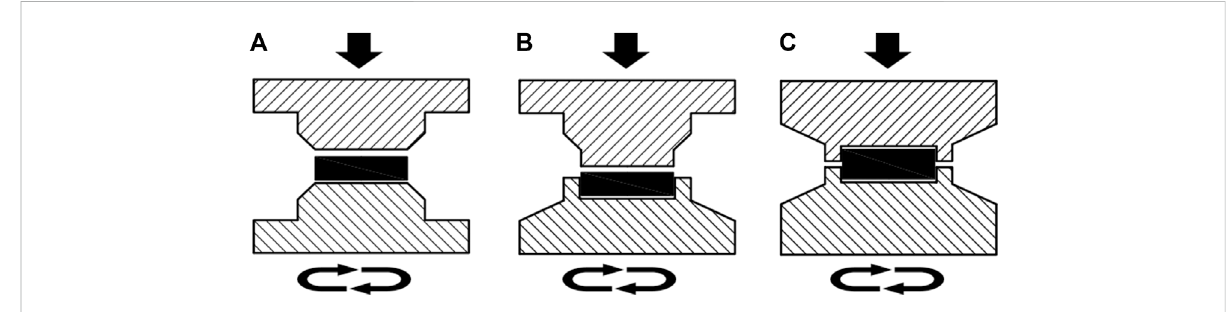
FIGURE 2 Schematical illustration of different conditions within the HPTed disk sample: (A) unconstrained; (B,C) constrained (Zhilyaev and Langdon,